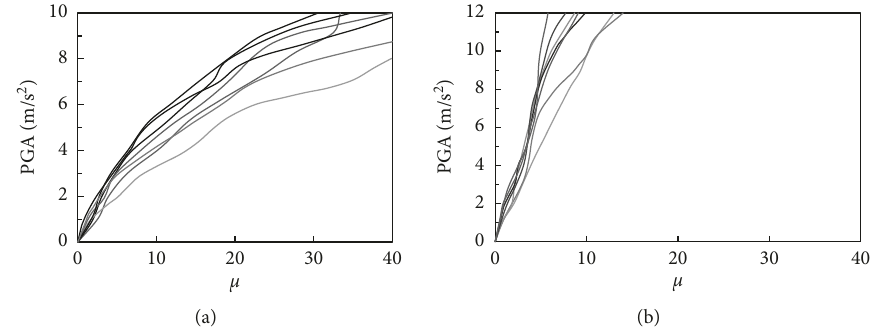
Figure 9: IDA curves of the BRB ductility: (a) response to near-fault ground motion; (b) response to far-fault ground motion.